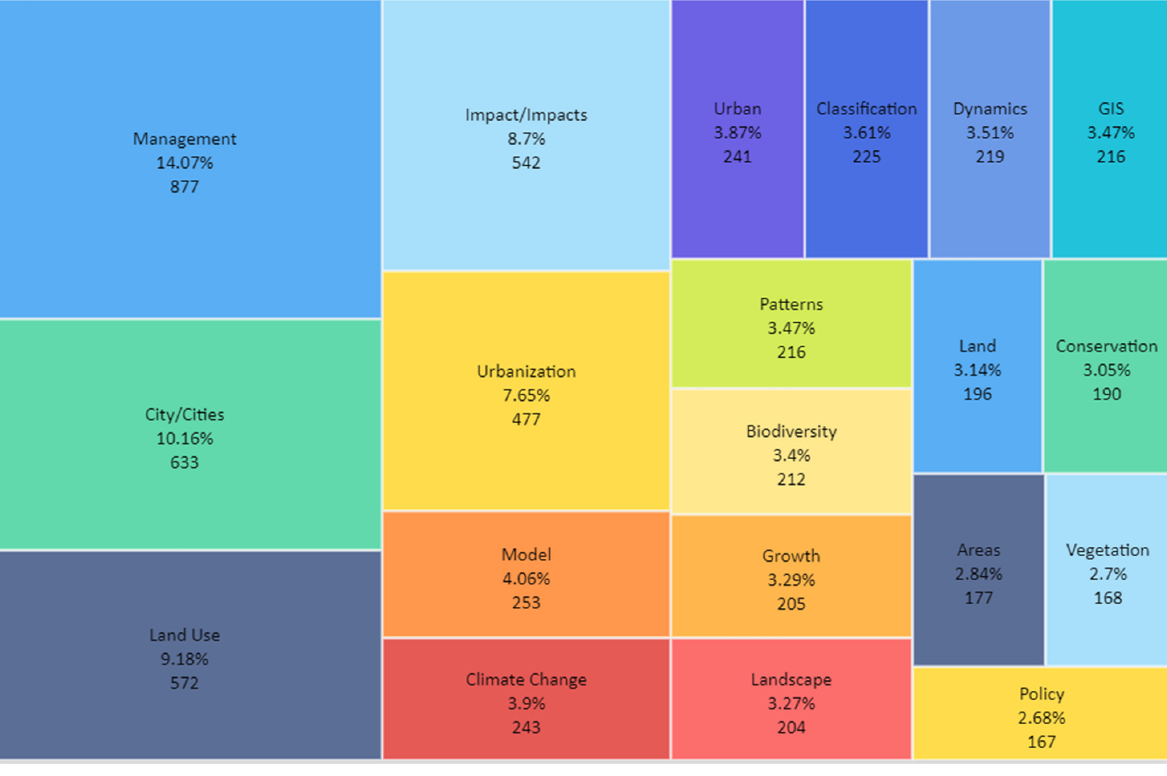
Figure 9. Tree map of high-frequency keywords in the field of urban land management in Web of Science from 1979 to 2021 (Top 20). Table 6. High-frequency keywords and frequency of occurrence in the field of urban land manage- ment (Top